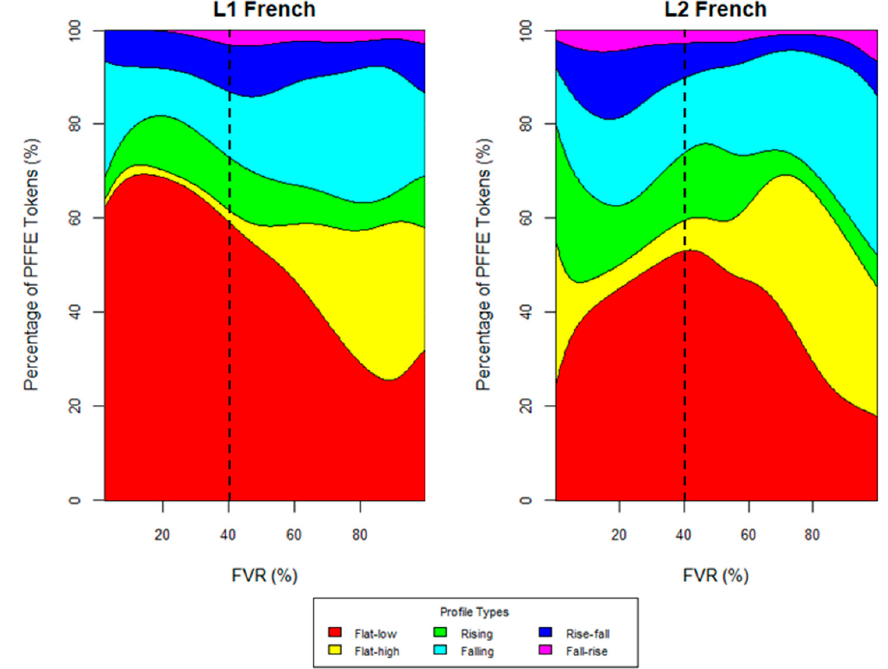
Figure 10. Profile types by speaker group and FVR. The dotted line at 40% indicates the approximate point at which the distribution of profile types